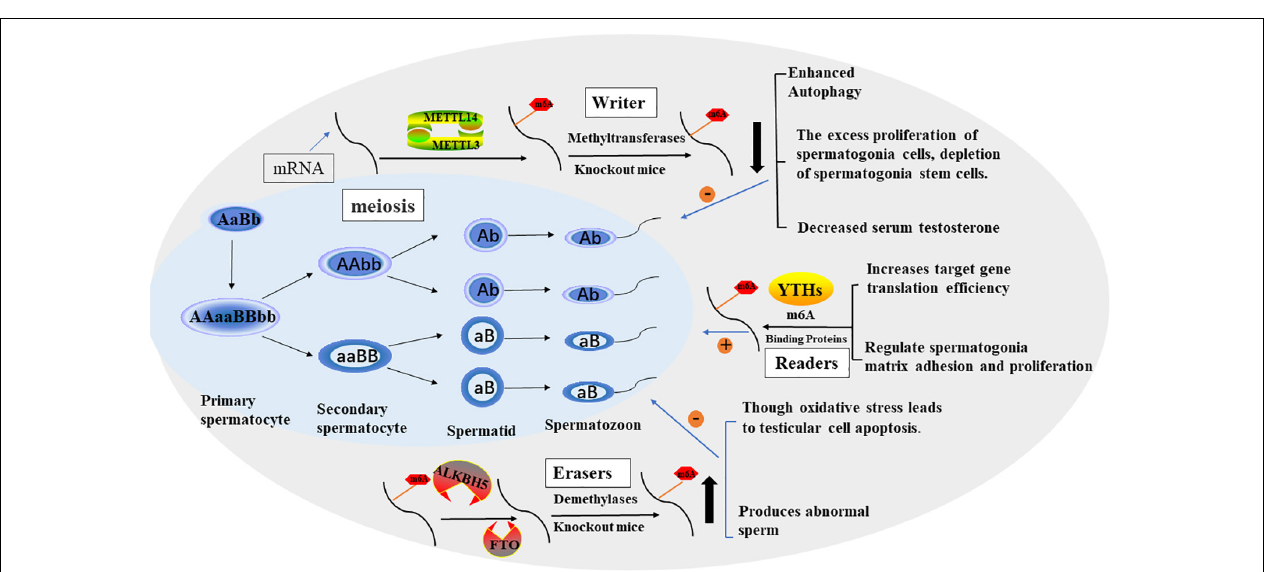
FIGURE 2 | The process of spermatogenesis and the potential role of m6A in spermatogenesis. The effect of M6A on male fertility is reflected in the regulation of spermatogenesis. In general, m6A modification promotes sperm production through various factors.